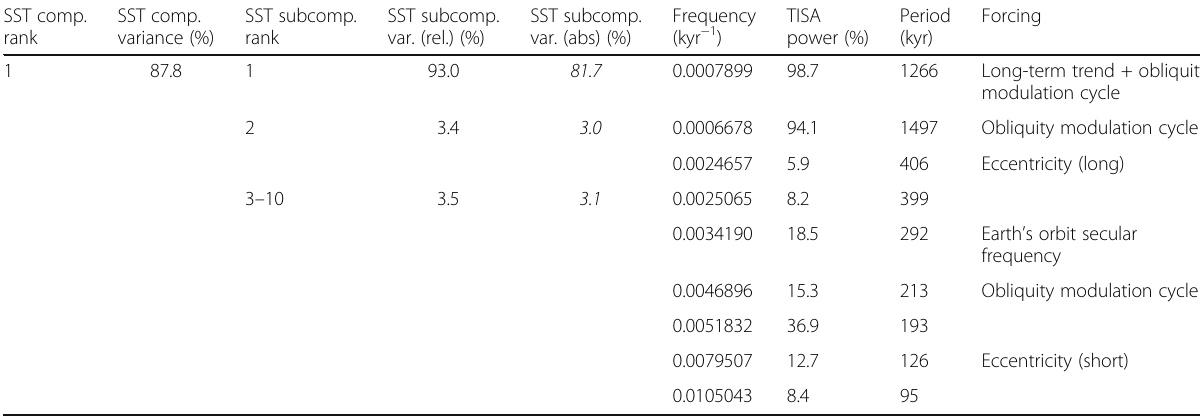
Table 5 Descriptive parameters and Fourier frequency results of the ODP Site 846 SST subcomponents isolated from the SST component-1 by singular spectrum analysis. The processing of the subcomponents was done to better separate and estimate the variance fraction of specific frequency bands from still complex data components. The italicized percentage values are the absolute variance of the subcomponents (referred to the total SST variance) SST comp.